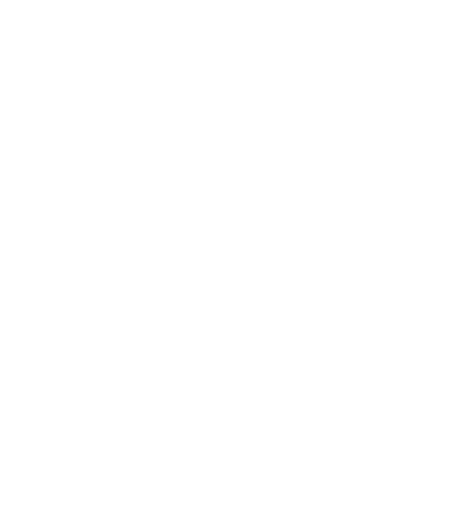
Figure 1. Flowchart over patient